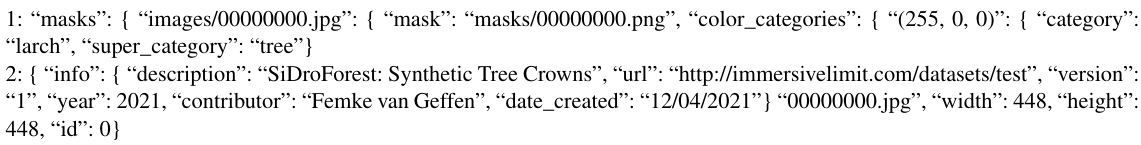
Table A2. Example of common objects in context (COCO) style annotation labels for the masks (1) and images (2).